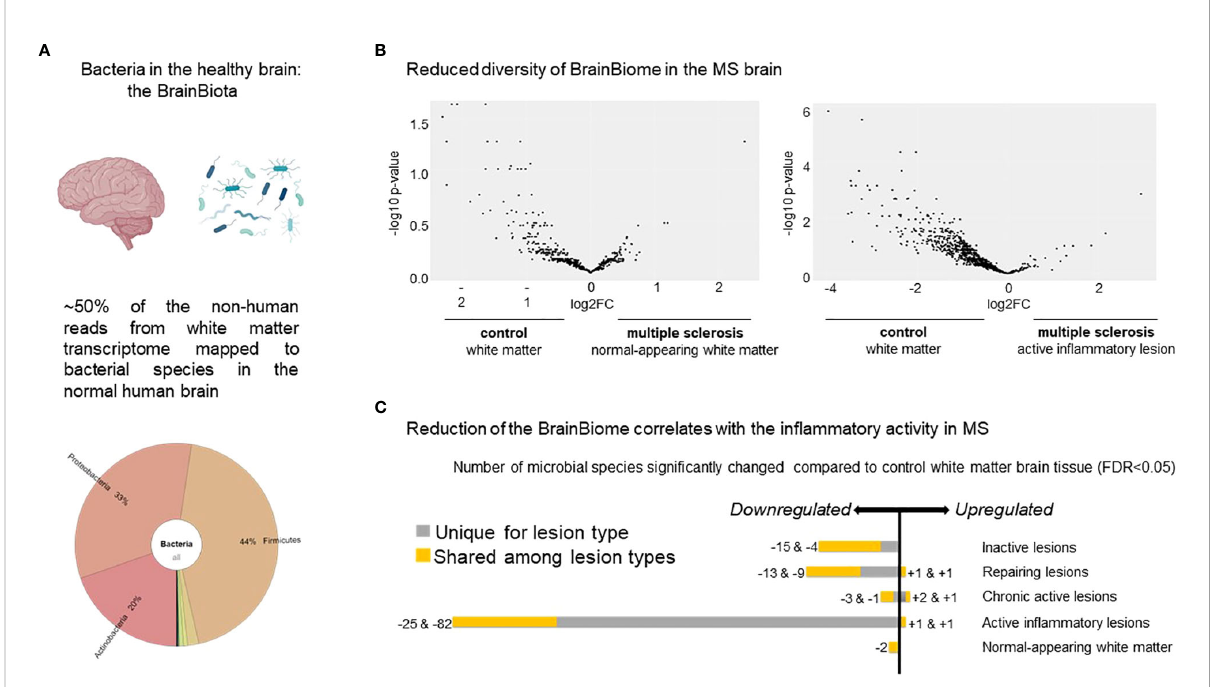
FIGURE 1 Distribution of microbes based on transcripts in the healthy brain and MS lesions. (A) Krona plot visualizing the distribution of the different microbes detected in the healthy brain based on RNA sequencing. The fi gure highlights the presence of three major bacterial phyla. (B) Volcano plot of the distribution of the different microbes represented by the dots based on differential expressed genes in NAWM vs control WM (n=90 transcripts) (left panel) and in active lesion type vs control WM (n=294 transcripts) (right panel). The fi gure indicates reduced diversity in both the MS NAWM and active lesions with in fl ammatory activity based on the higher expressed transcripts from different microbes in control WM. (C) Number of microbes signi fi cantly changed in the different MS white matter lesion types compared to control WM. Note the most reduced diversity in the active lesions with the highest in fl ammatory activity. The bacteria and brain are created by